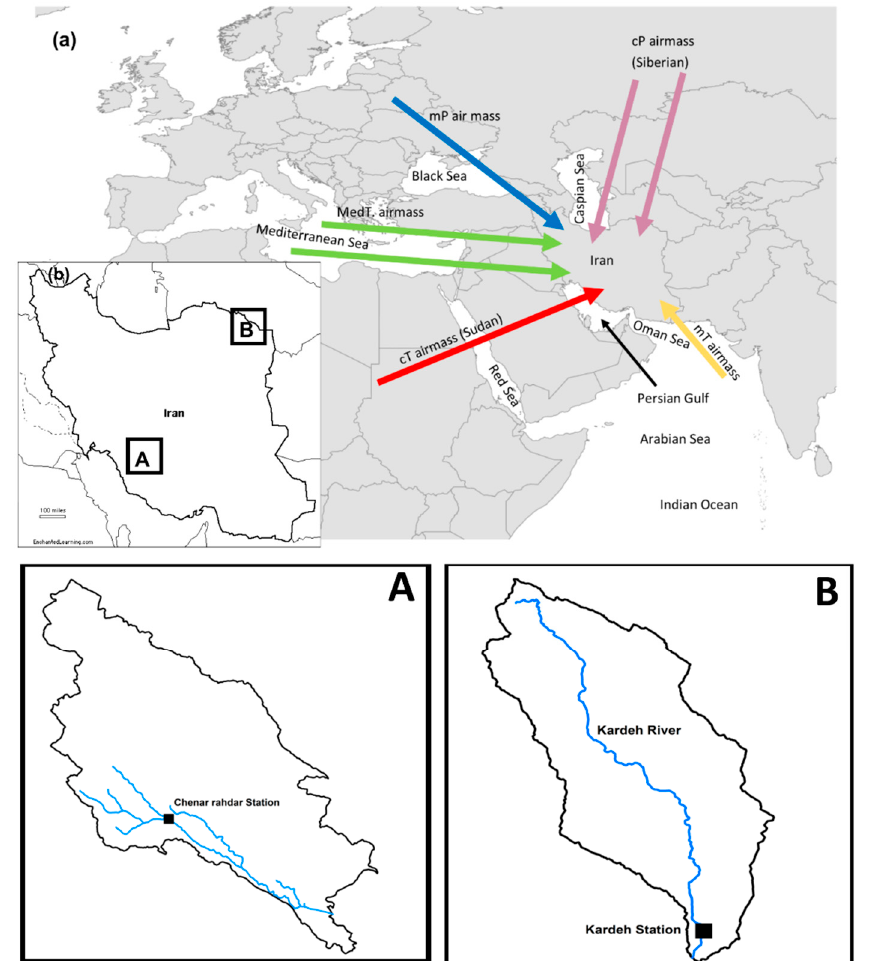
Figure 1. ( a ) Air masses influencing Iran and ( b ) spatial distribution of the Shiraz ( A ) and Mashhad ( B ) boxes in Iran plateau.